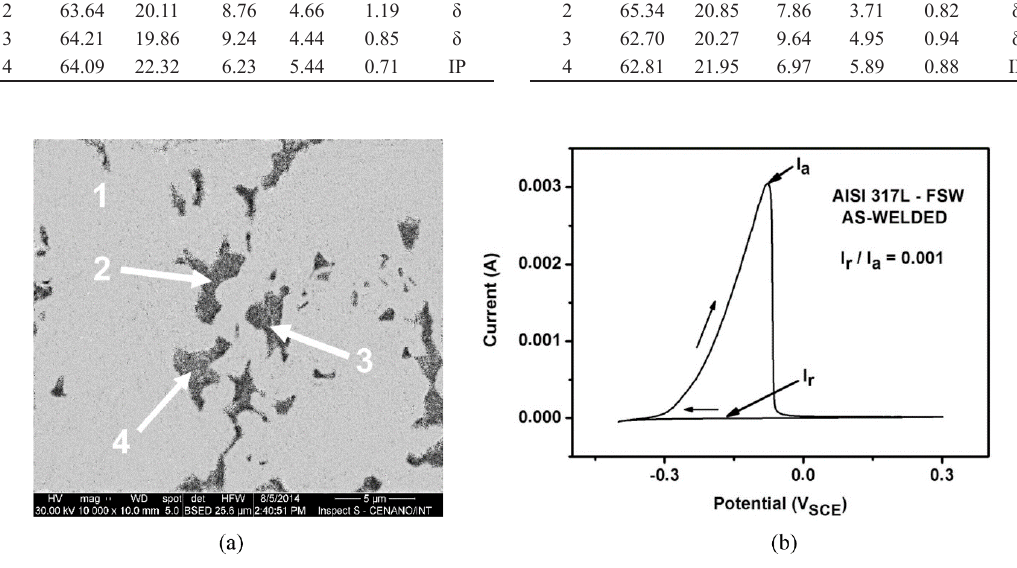
Figure 2. (a) Microstructure and (b) DL-EPR curve of specimen as welded.